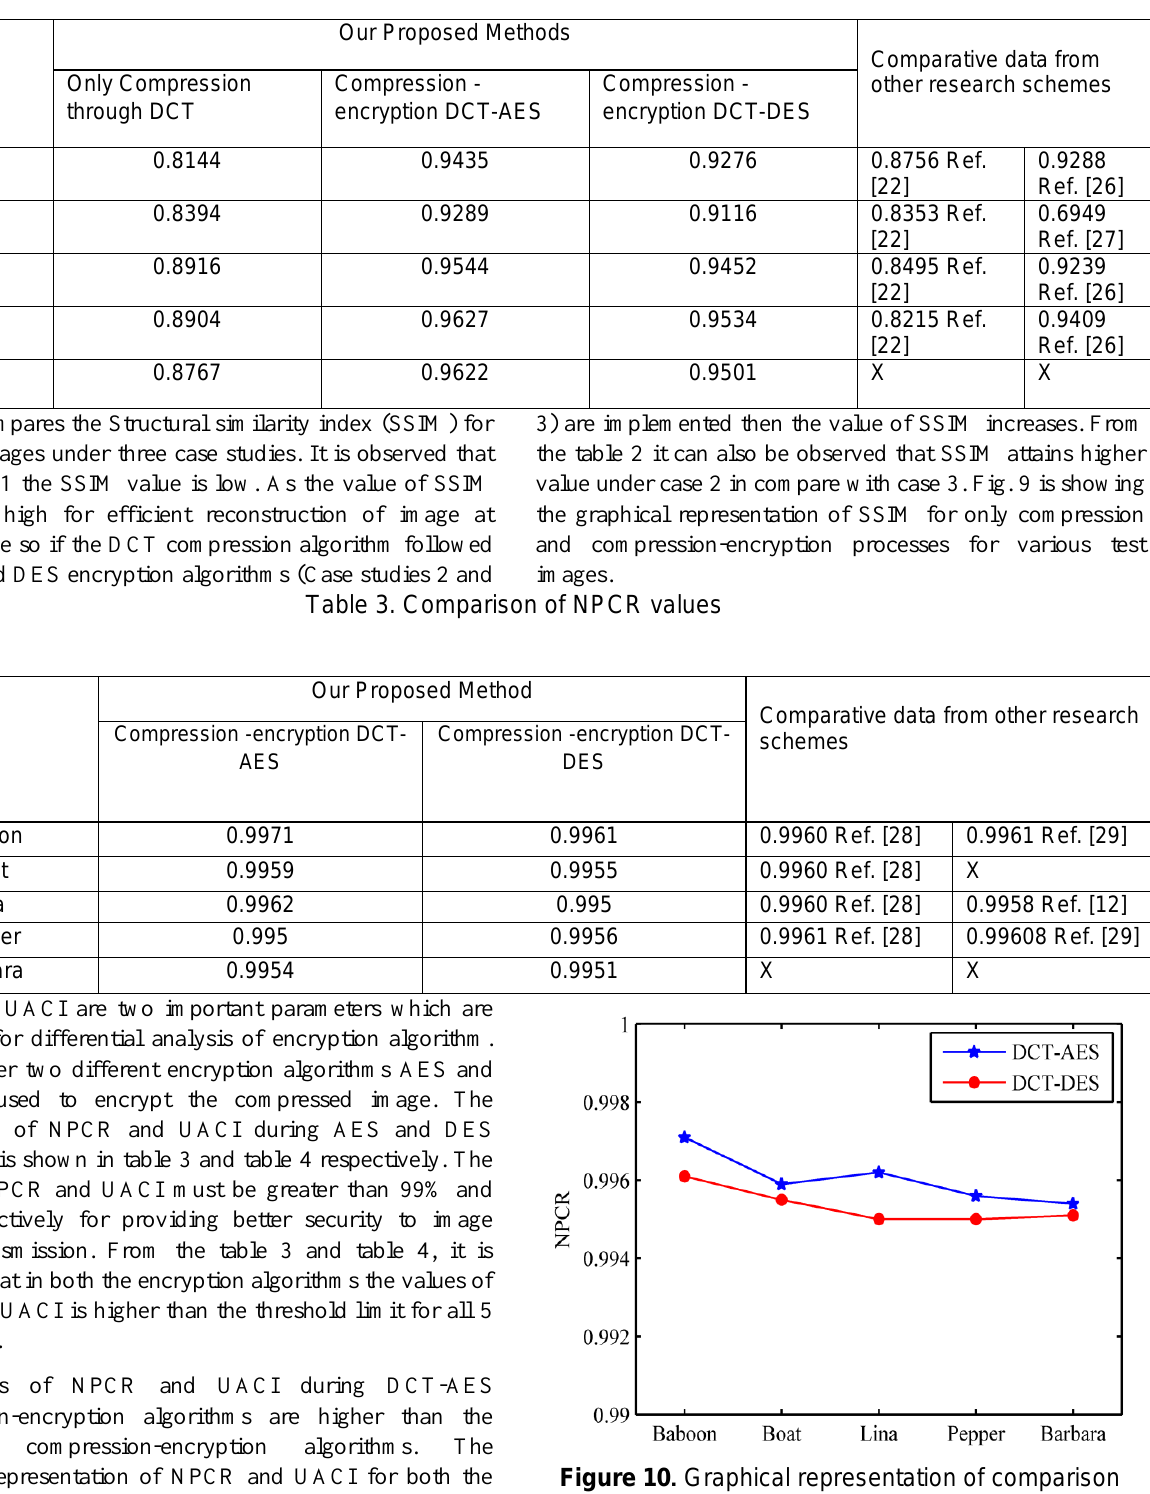
Table 2. Comparison of SSIM values